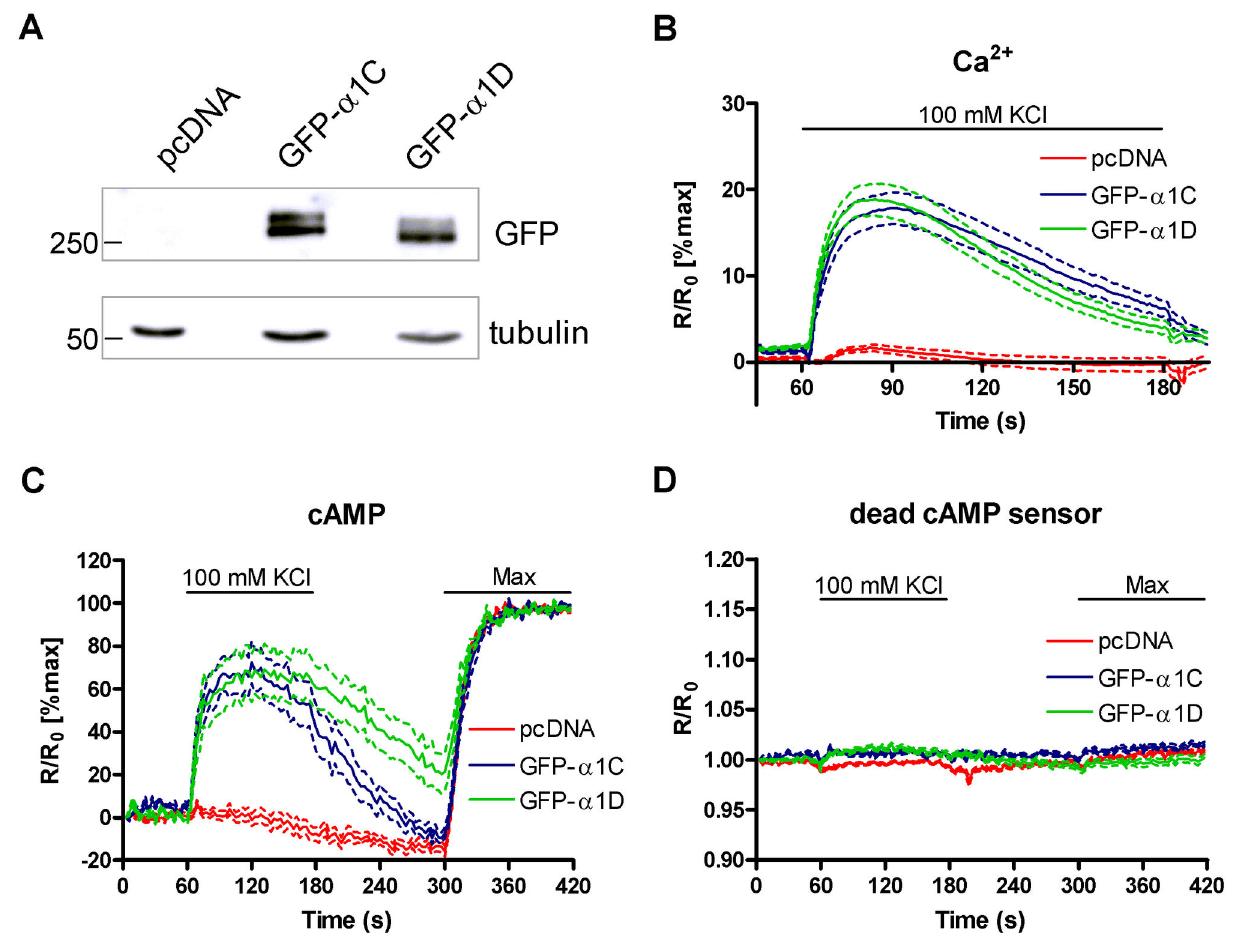
Figure 5. Overexpression of VGCCs in HEK293 facilitates AC8 activation. ( A ) Western blot demonstrating the overexpression of GFP-α1C and GFP-α1D in HEK293 cells. Tubulin was used as a loading control. ( B ) Ca 2+ measurements in fura-2 loaded HEK293 cells transfected with empty vector, GFP-α1C or GFP-α1D. Cells were depolarised with 100 mM KCl in the presence of 2 mM Ca 2+ . Cells which showed no response were assumed not to express the channel subunit and so were excluded from the analysis. n=150 (pcDNA), 39 (GFP-α1C) and 57 (GFP-α1D) cells from 3-4 independent experiments. ( C ) cAMP measurements in HEK293 cells co-expressing Ci/Ce Epac2-camps AC8 and the indicated channel. Cells were depolarised with 20 mM KCl in the presence of 2 mM Ca 2+ . n=28 (pcDNA), 17 (GFP-α1C) and 18 (GFP-α1D) cells from 4-5 independent experiments. ( D ) Control and 24 (GFP-α1D) cells from 4 independent experiments. On all graphs dotted lines represent